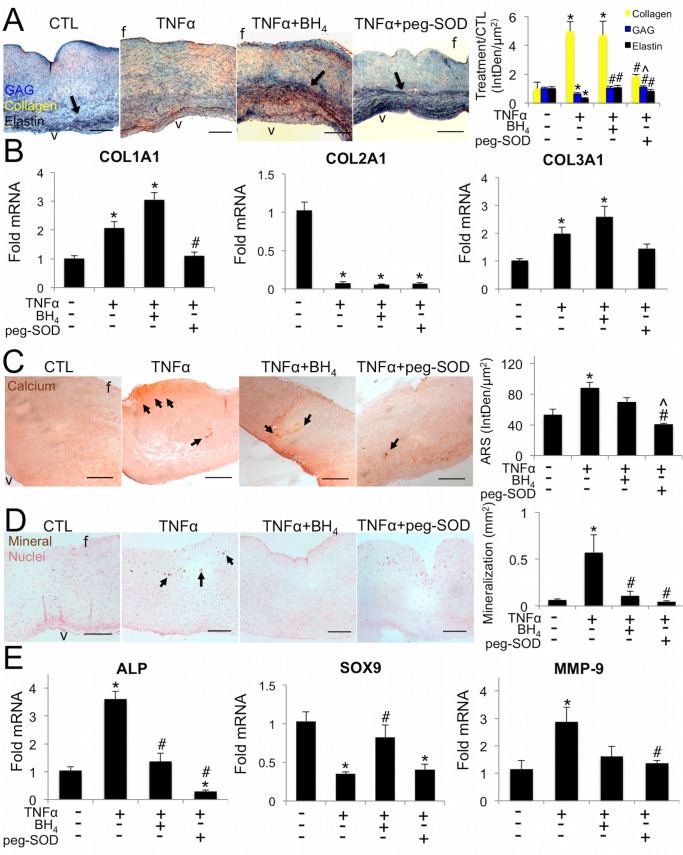
TNFα induces early calcification and changes in aortic valve extracellular matrix composition and structure, rescued differentially by BH4 or peg-SOD.
A, TNFα increased collagen and decreased GAG and elastin (arrows). BH4 maintains GAG and elastin at control levels, but does not block increases in collagen. Peg-SOD significantly reduced collagen compared to TNFα and maintained control levels of GAG and elastin (Blue: glycosaminoglycans, Red: mucins, Yellow: collagen, Black, elastin). B. TNFα increased synthesis of COL1A1 and COL3A1 mRNA, rescued by peg-SOD but not by BH4. COL2A1 was decreased in all treatment conditions. * indicates p < 0.05 versus control, # indicates p < 0.05 versus TNFα. N = 6. One-way ANOVA with Tukey’s post hoc test were used to compare means. C, TNFα increased calcium deposition (Alizarin Red S stain) that is rescued by BH4 or peg-SOD. D, TNFα increased mineralization (von Kossa stain), rescued by BH4 or peg-SOD. E, TNFα increased alkaline phosphatase, decreased Sox9, and increased MMP-9 mRNA, rescued differentially by BH4 or peg-SOD. Representative images from n = 6 leaflets per condition. Scale bar = 200μm. * indicates p < 0.05 versus control, # indicates p < 0.05 versus TNFα, ^ indicates p < 0.05 versus TNFα+BH4. N = 6.